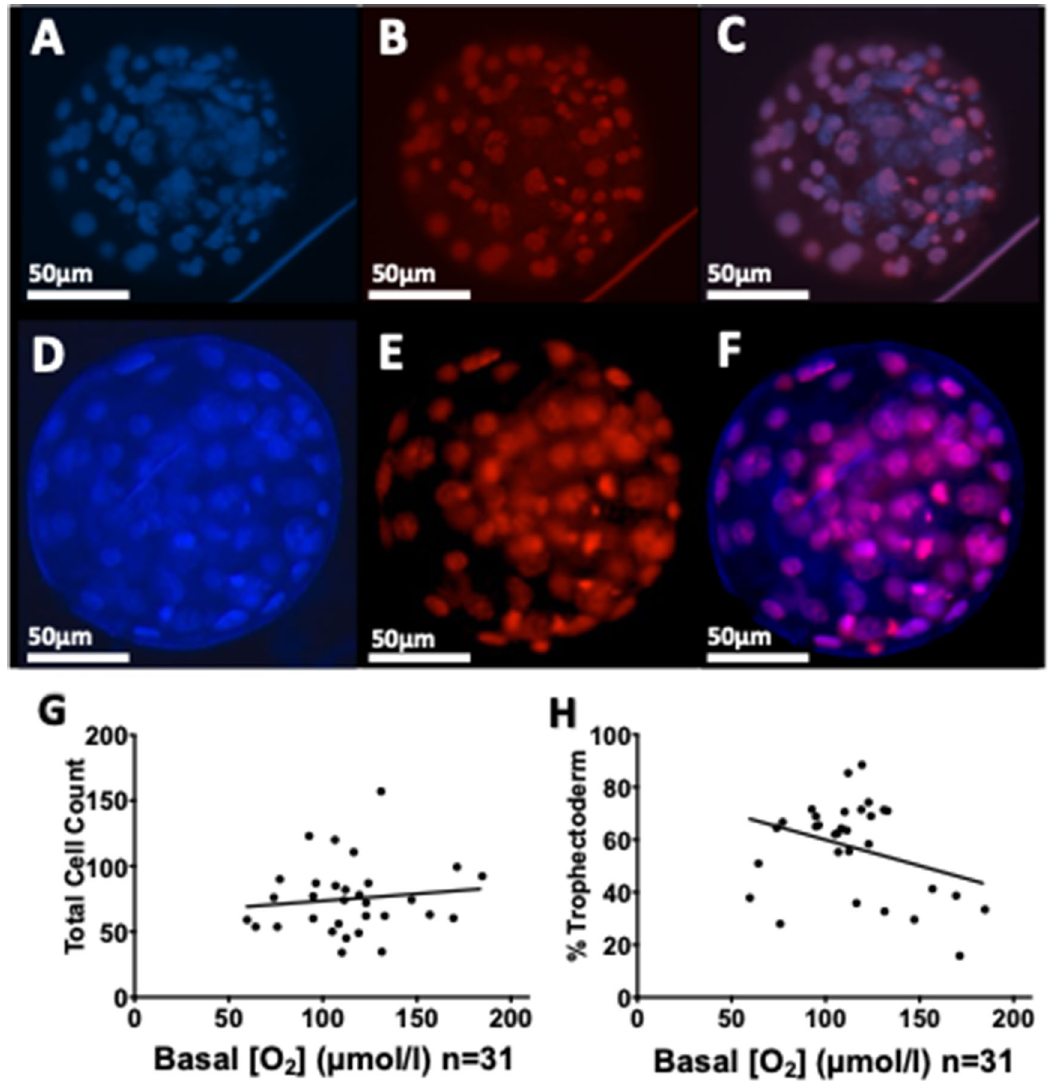
Figure 5. Blastocyst cell allocation and basal oxygen concentration. Examples shown of Hoechst total cell staining ( A , D ), Propidium Iodide (PI) Trophectoderm staining ( B , E ), combined channels ( C , F ). ( G ) Basal icO 2 versus total cell count with line equation y = 0.1086x + 62.62, R 2 = 0.015, p = 0.52. ( H ) Basal oxygen concentration versus % Trophectoderm with line equation y = 0.1974x + 79.68, R 2 = 0.11, p = with LC embryo icO 2 significantly higher than that of mature oocytes (p < 0.05) and blastocyst icO 2 signficiantly higher than that of both mature oocytes (p < 0.005) and LC embryos (p < 0.05). Blastocyst ICM and TE visual analysis. Blastocyst images were examined in ImageJ to compare MM2 signal intensity between whole blastocysts, ICM and TE regions (Fig. 4A–C). Mean overall blastocyst basal icO 2 was 129.23 ± 30.54 µmol/l (n = 82, Fig. 4D). Trophectoderm (TE) oxygen concentration (134.10 ± 32.18 µmol/l) was significantly higher than ICM or overall (p < 0.0001). Inner Cell Mass (ICM) icO 2 (118.33 ± 29.57 µmol/l) was significantly lower than either TE or overall (p < 0.0001). Blastocyst cell allocation ratios. Blastocyst total cell counts (representative images: Fig. 5A–F) varied from 34 to 157 cells and were not normally distributed (n = 31; p = 0.01). Blastocyst cell allocation ratio (% TE) varied from 16 to 88% and were normally distributed (n = 31; p = 0.35). Neither total cell count (75 ± 4.8%; p = 0.07; Fig. 5G), nor cell allocation (57 ± 3.2%; p = 0.52; Fig. 5H) correlated with icO 2 . Mitochondrial DNA. number did not vary significantly between immature oocytes (1.8 × 10 5 ± 1.6 × 10 4 copies; n = 10), mature oocytes